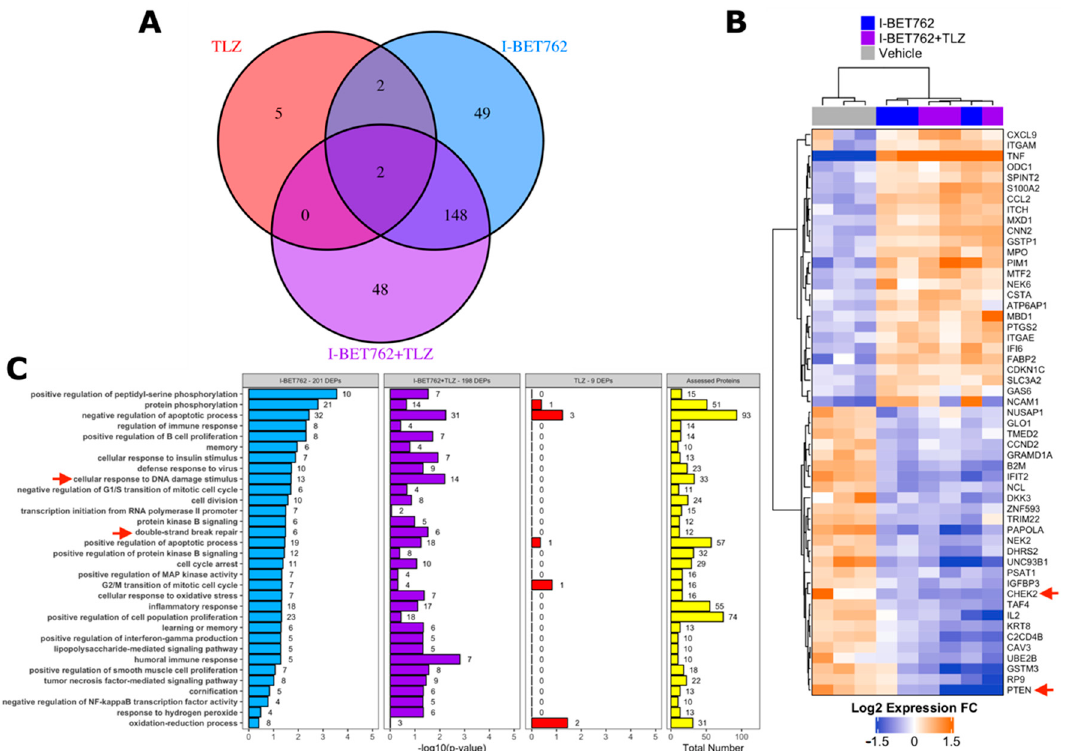
Figure 5. Cancer-related proteome profile of I-BET762- and Talazoparib-treated Lu135 SCLC cells. ( A ) Venn diagram of I-BET762-single agent (I-BET762), Talazoparib-single agent (TLZ) or drug combination (I-BET762+TLZ) associated differentially expressed or phosphorylated proteins (DEPs). DEPs were defined by an expression or phosphorylation level difference of at least 30% between treated and untreated cells (fold change at log2 scale > 0.3785 or < − 0.3785 and adjusted p -value < 0.05). ( B ) Heatmap of the top-20 down-regulated (blue) and top-20 up-regulated (orange) proteins following I-BET762 or I-BET762+TLZ treatment. The data presented are mean normalized by row. CHEK2 and PTEN (red arrows) are down-regulated in both I-BET762 and I-BET762 treatment groups. ( C ) Pathway enrichment analysis of “biological process” Gene Ontology aspect in DEPs. Ontology classes with Fisher exact test p -value < 0.05 in at least one treatment group are shown and ranked based on p -value in I-BET762 treatment group.